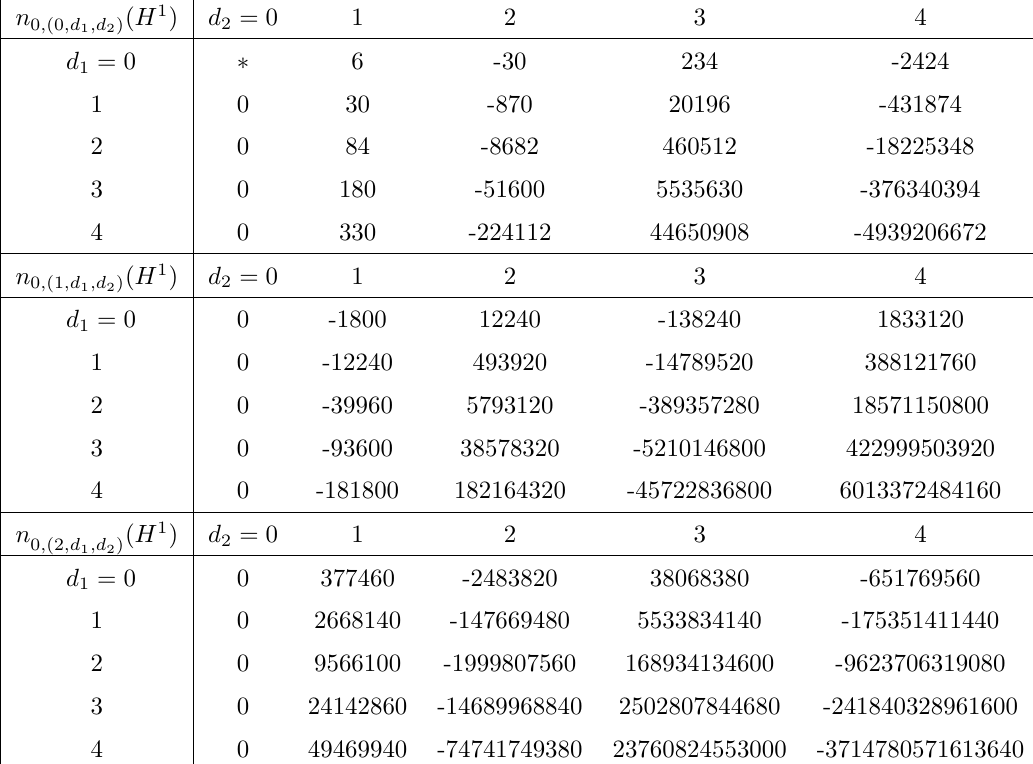
Table 5 . Genus 0 invariants associated to H 1 of M E 8 P 1 × P 2 for degree d e = 0 , 1 , 2 of the elliptic